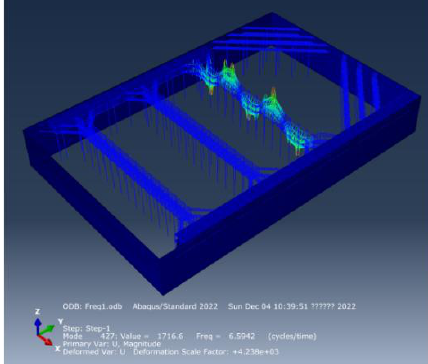
Figure 6. Vertical second-order vibration mode (6.31 Hz).